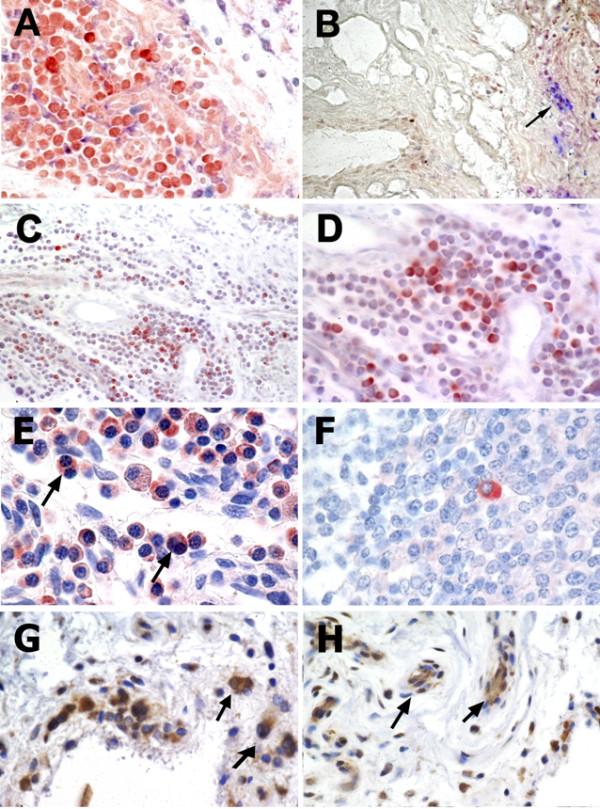
Dual immunostaining for TWEAK and cell lineage markers and cells expressing Fn14. Dual immunostaining for TWEAK (red) and CD68 (blue) in inflamed synovial tissue from a patient with active RA (A). Dual immunostaining for TWEAK (red) with CD38 (blue) with co-expression of TWEAK and CD38 (purple) indicated by arrow (B). C) and D) Dual immunostaining for TWEAK (red) with CD22 (blue). E) TWEAK expression (red) in multinucleated cells (indicated by arrows), and F) by plasma cells in tonsil tissue. Expression of Fn14 (brown) in multinucleated cells (G), and blood vessels of the synovial tissue (H), indicated by arrows. Sections shown in E, F, G, and H were counterstained with haematoxylin. Images shown in B and C were obtained with obj ×10; image shown in A obtained with obj ×20, D, F, G, H with obj ×40 and E with obj ×60.